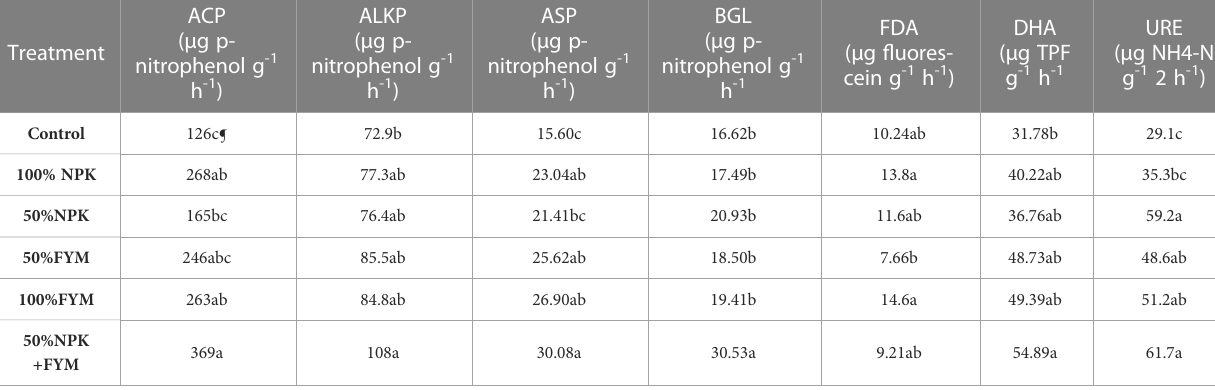
TABLE 4 Effect of long-term fertilization and manuring on activities of various enzymes. Treatment